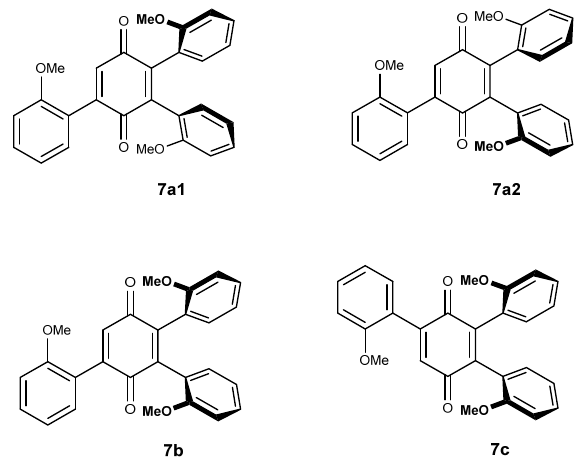
Figure 4. The four possible tri-adducts 7a1 , 7a2 , 7b and 7c .